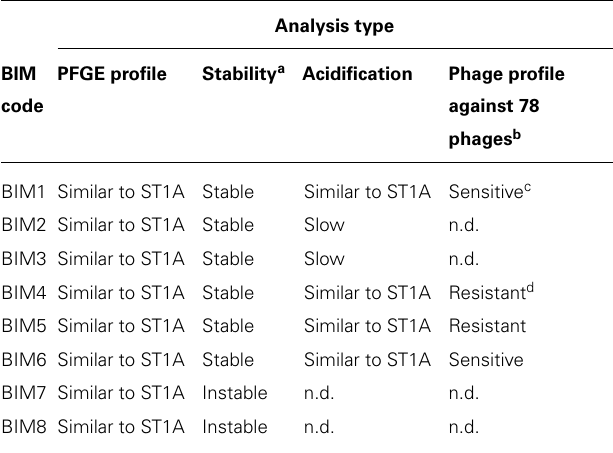
Table 1 | Genetic and physiological tests performed on the eight BIMs generated from the phage-sensitive strain ST1A. Analysis type